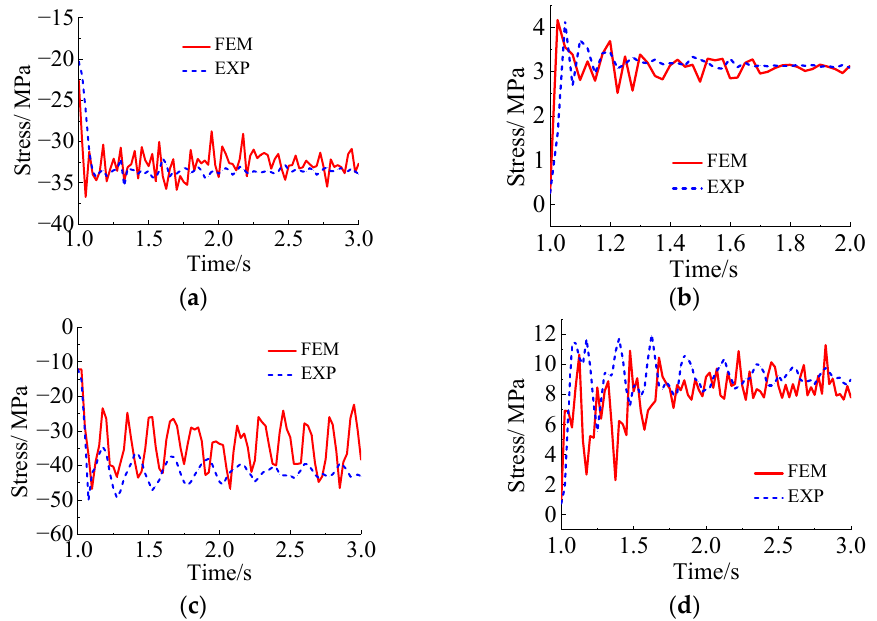
Figure 14. The time history plots of the stress due to the breakage of the long and short suspenders: ( a ) stress of the arch rib when the 1# suspender breaks; ( b ) stress of the bridge deck system when the 1# suspender breaks; ( c ) stress of the arch rib when the 6# suspender breaks; ( d ) stress of the bridge deck system when the 6# suspender breaks .